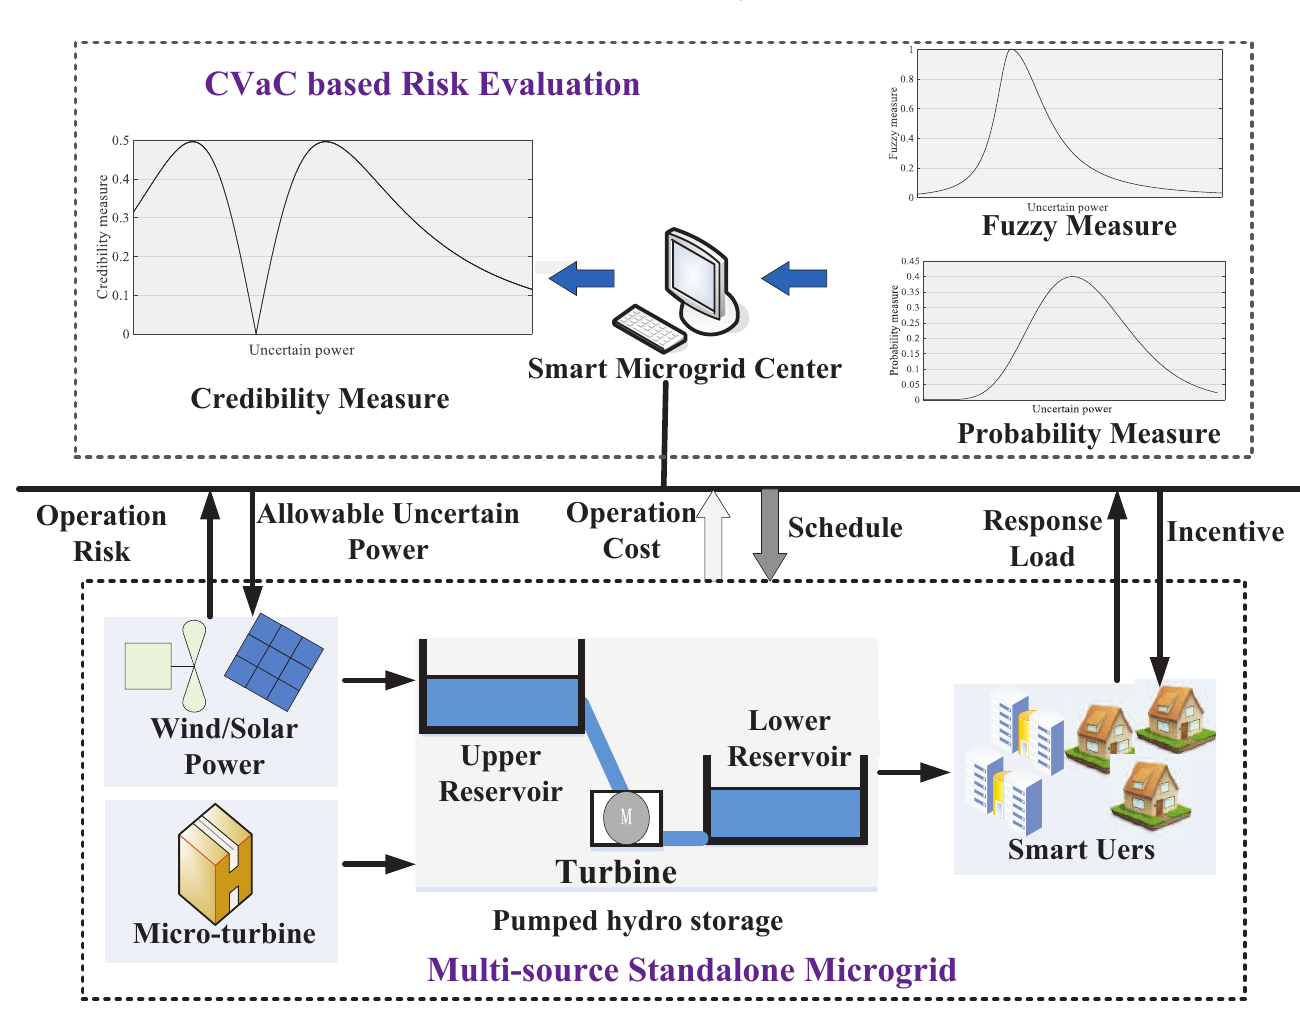
Figure 1. Configuration of the